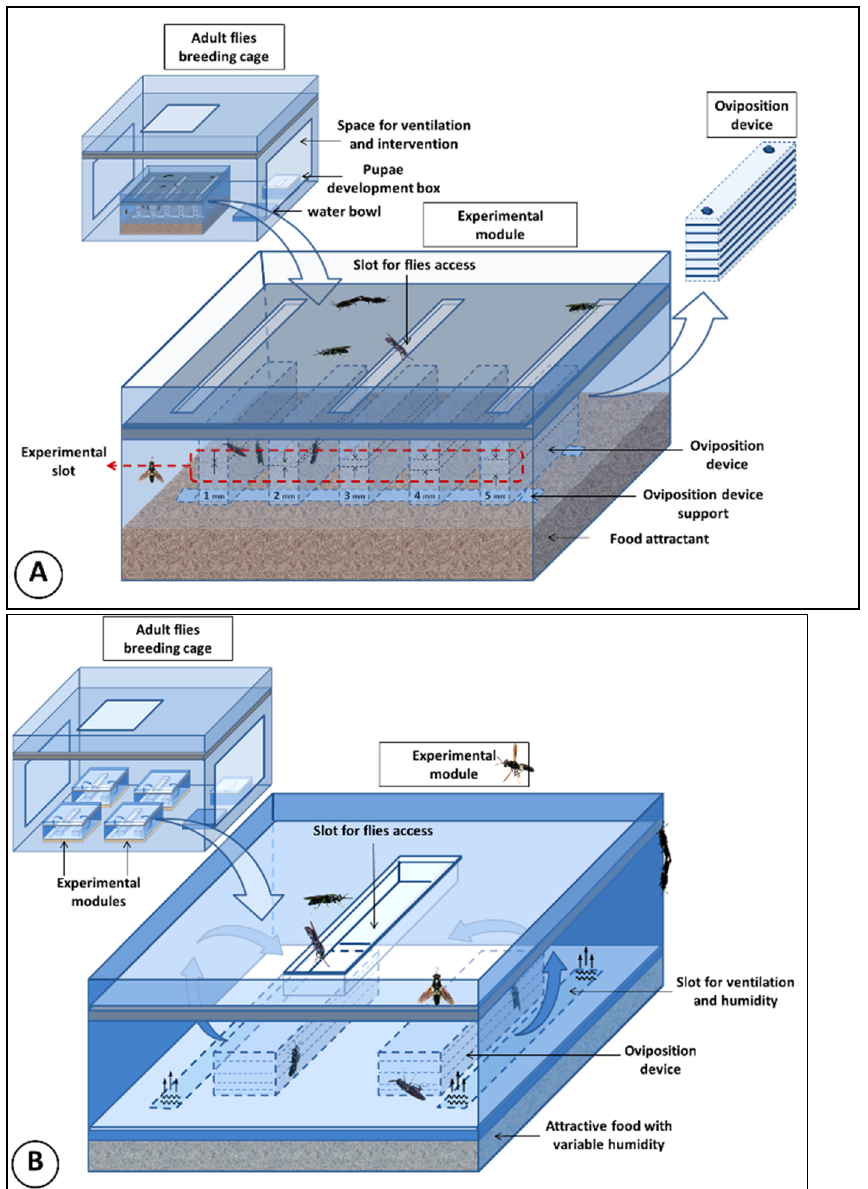
Figure 1. ( A ) Experimental device for evaluating the behavioral peculiarities of laying eggs according to the size of the oviposition slots. ( B ) Experimental device to evaluate the influence of substrate moisture on ovipositing behavior in Hermetia illucens.